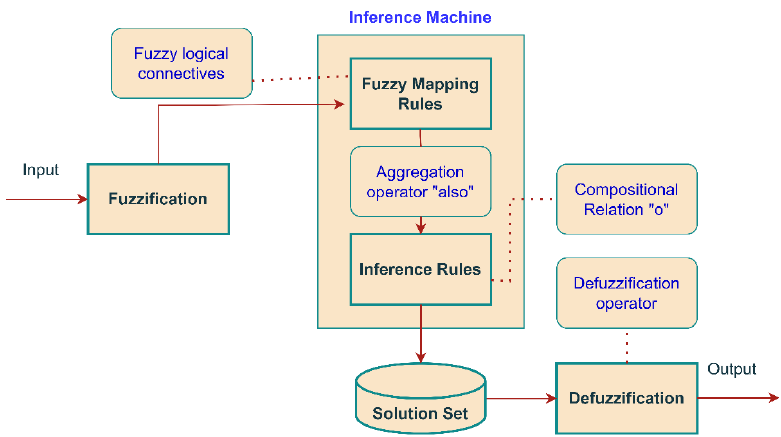
Figure 1. Fuzzy inference mechanism on the expert and control systems.